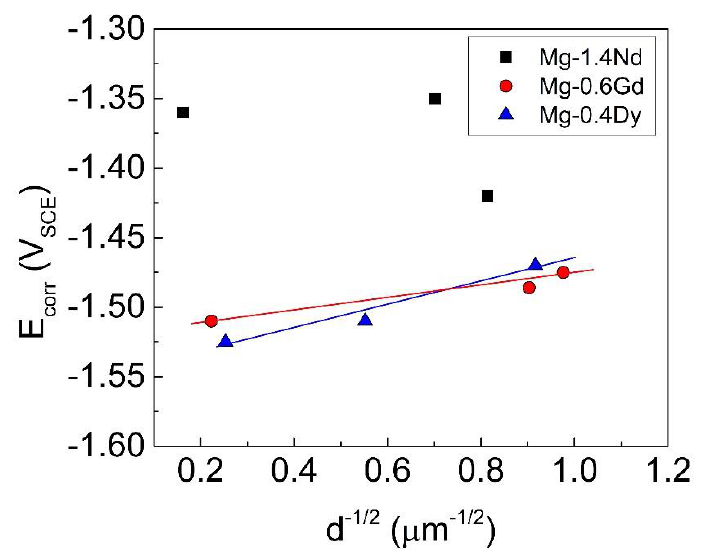
Figure 10. Evolution of E corr as a function of d − 1/2 for HPT-processed and annealed Mg-1.4Nd, Mg-0.6Gd, and Mg-0.4Dy samples.